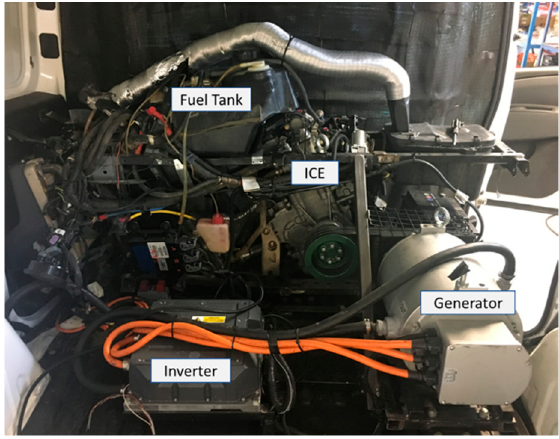
Figure 7. APU architecture—ICE, generator and inverter integration on the vehicle. Experimental fuel consumption values were obtained from fuel-consumption tests.